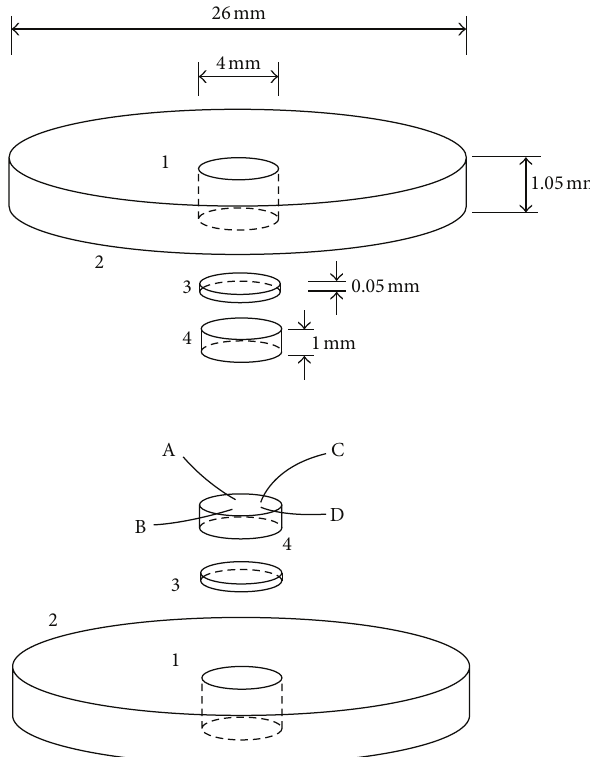
Figure 1: Sample assembly for measuring electrical resistivity of PAN. 1: hole, 2: pyrophyllite, 3: mica disc, 4: sample PAN, and A– D: Cu